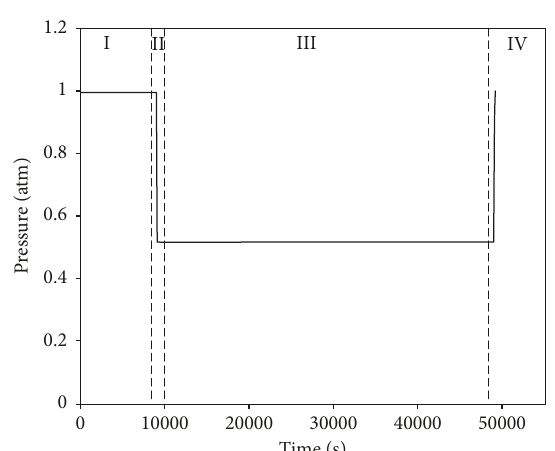
Figure 8: Pressure history of the adsorption column during one cycle for a VOCs mixture of dichloromethane/acetone (3000 ppm/1500ppm).